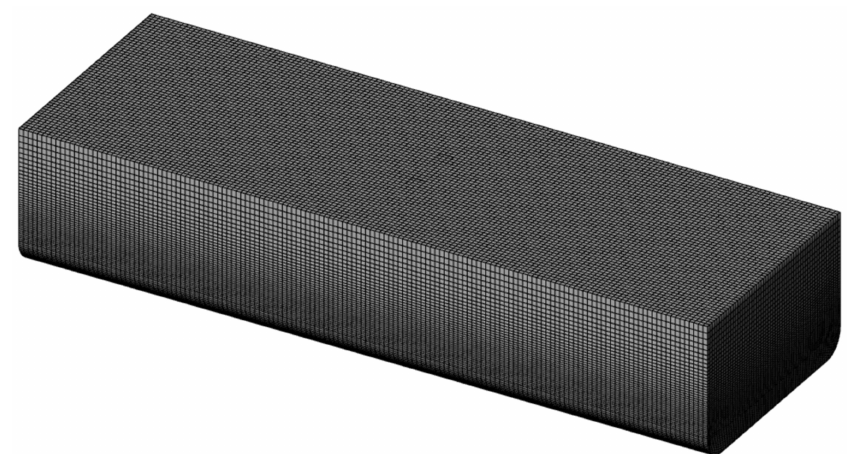
Figure 6. Surface grid of the ship.